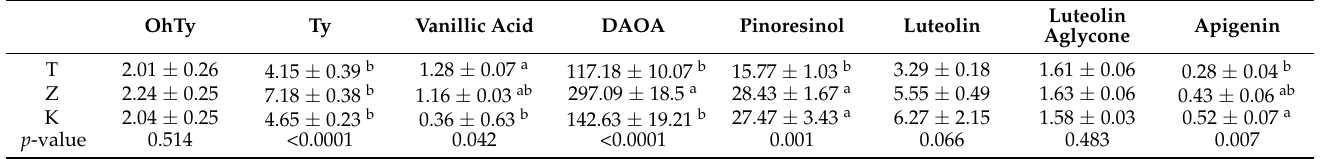
Hydroxytyrosol (OhTy) is expressed as mg/kg tyrosol; tyrosol (TY) is expressed as mg/kg of tyrosol; deacetoxy oleuropein aglycon (DAOA) is expressed as mg/kg of oleuropein, while the other compounds are expressed as mg/kg of relative standard. Table 5. Tocopherol and carotenoid content in oil produced under different foliar treatments (T = untreated control, Z = zeolitite, K = kaolin) Values are mean ± standard deviation. Compounds are expressed as mg of relative standard compound per kg of oil. Different letters in the same column indicate significant difference ( p < 0.05) according to Tukey’s honestly significant difference (HSD)